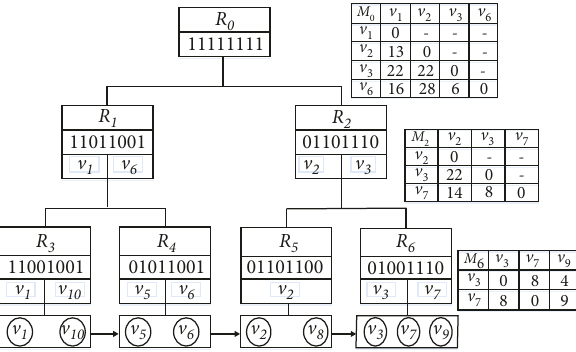
Figure 6: G-tree index